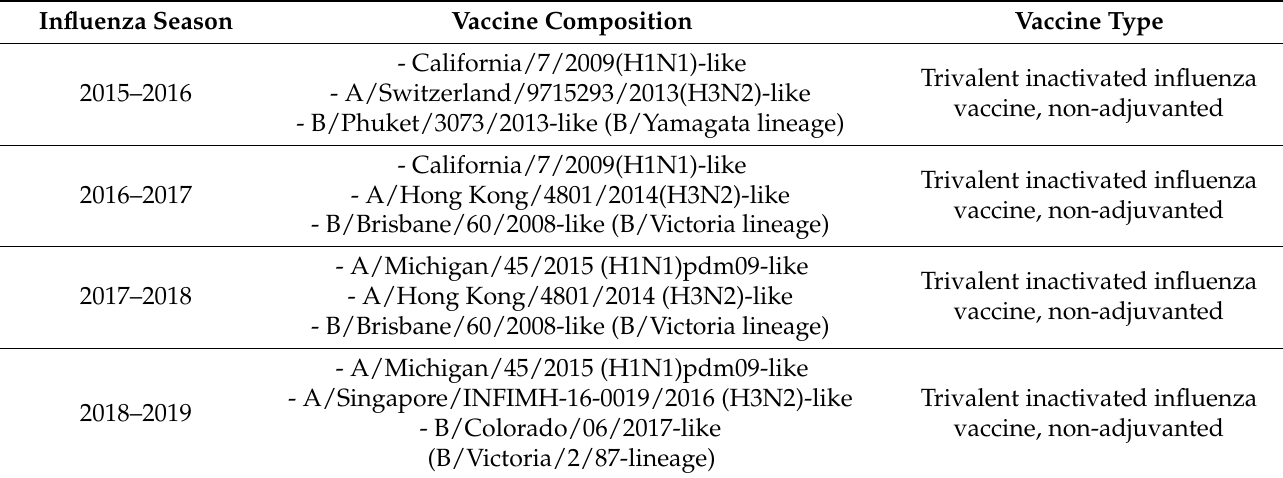
Table 1. Free-of-charge vaccines used to vaccinate risk group patients in Lithuania in the 2015–2019 influenza seasons. Influenza